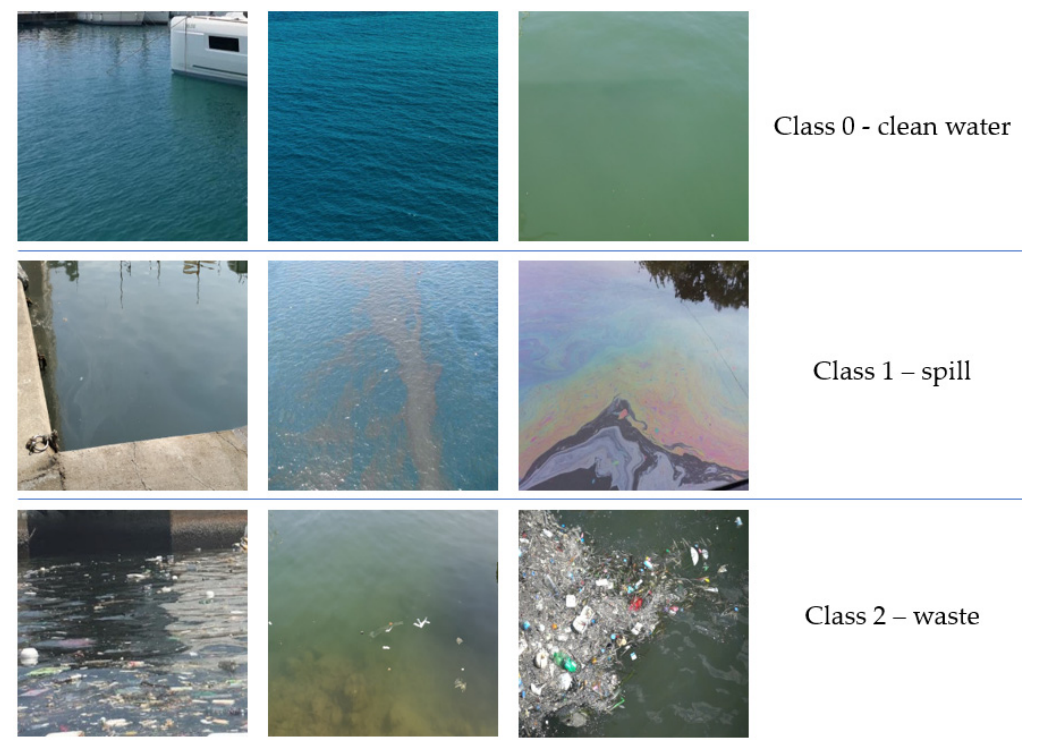
Figure 5. Example images for each class.